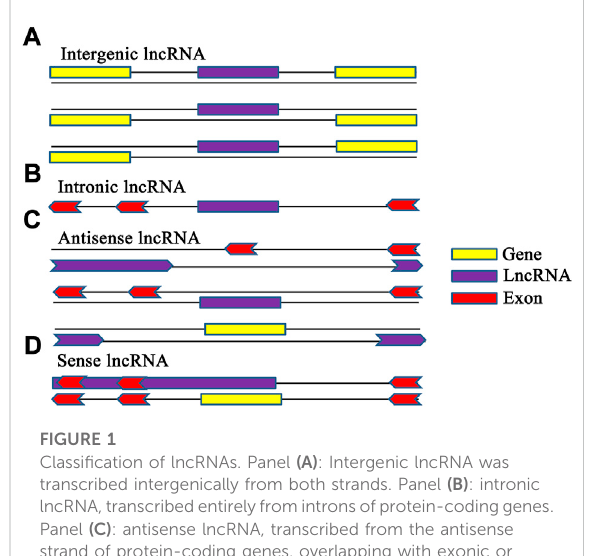
FIGURE 1 Classi fi cation of lncRNAs. Panel (A) : Intergenic lncRNA was transcribed intergenically from both strands. Panel (B) : intronic lncRNA,transcribedentirelyfromintronsofprotein-codinggenes. Panel (C) : antisense lncRNA, transcribed from the antisense strand of protein-coding genes, overlapping with exonic or intronic regions or covering the entire protein-coding sequence through an intron. Panel (D) : Sense lncRNA was transcribed from the sense strand of protein-coding genes and contain exons from protein-coding genes, overlapping with part of protein-coding genes or covering the entire sequence of a protein-coding gene through an